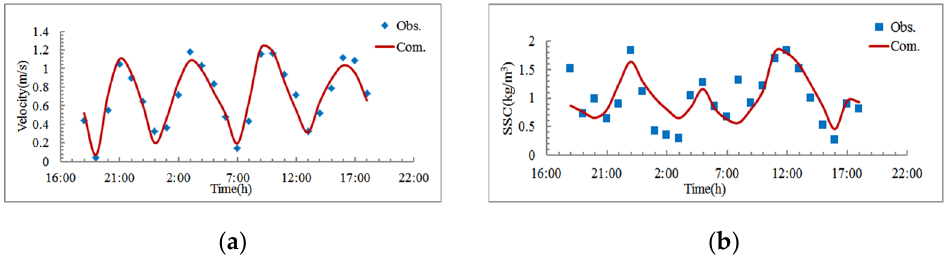
Figure 7. Calibrations of the tidal current ( a ) and bottom suspended sediment concentration ( b ) at the gauge site.